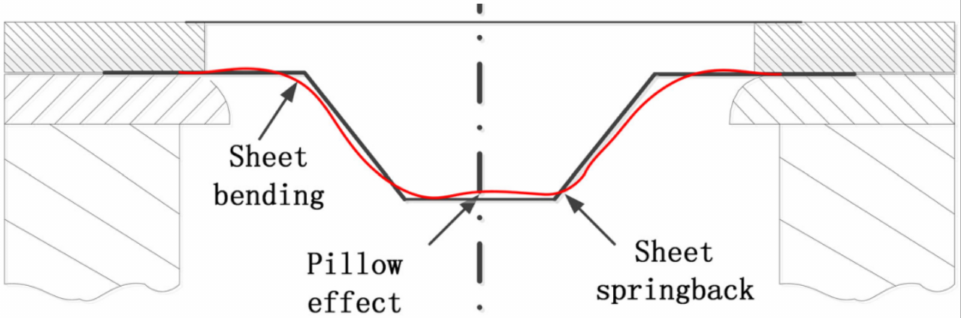
Figure 16. Geometric errors during the SPIF process (reproduced with permission from [113]; copyright © 2007 Elsevier B.V. All rights